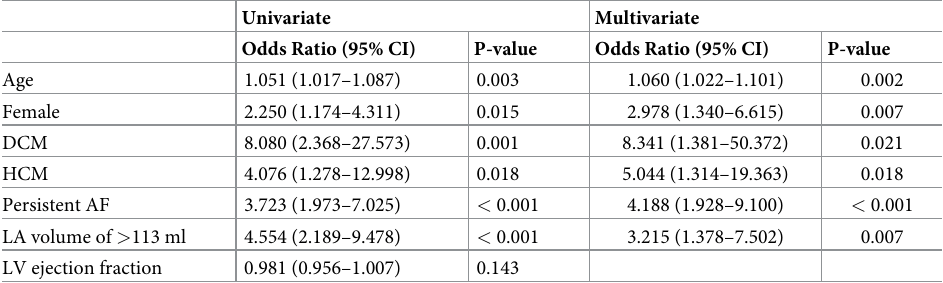
Table 2. Predictors of